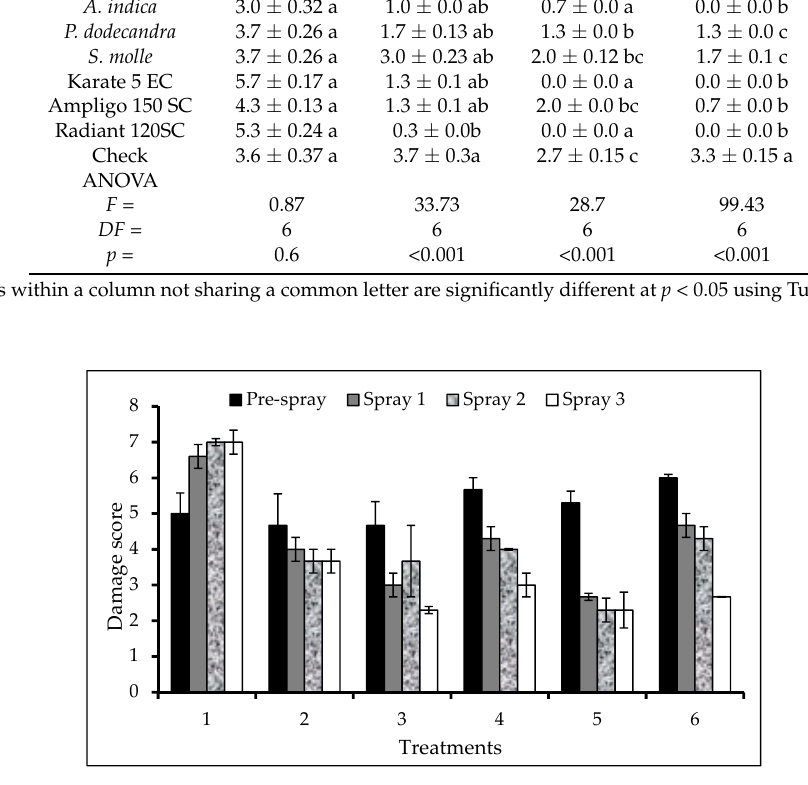
Figure 3. Mean (± SEM) of leaf damage of maize by FAW under different treatments in the field. Note: (T1) A. indica alone sprayed for three applications; (T2) Karate 5 EC alone sprayed for three applications; (T3) A. indica sprayed in the first and second applications with Karate 5 EC sprayed in the third application; (T4) A. indica sprayed in the first application with Karate 5 EC sprayed in the second and third application; (T5) A. indica sprayed in the first application with Karate 5 EC sprayed in the second round; (T6) Unsprayed